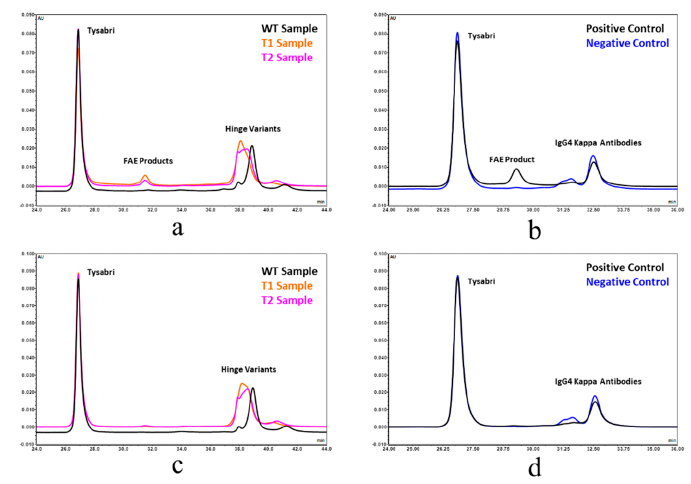
Figure 8. Blocking Fab arm exchange of hinge deleted mAbs by CH3 stabilization monitored by chromatographic separation. Propensity of IgG4 hinge deleted (T1), R409K CH3 stabilized IgG4 hinge deleted (T2), and S228P hinge stabilized full length IgG4 (WT) to engage in Fab arm exchange with Tysabri ® in the presence ( a ) or the absence ( c ) of 1 mM GSH reducing agent was analyzed by chromatographic separation. An FAE positive control reaction was conducted by monitoring the formation of the bispecific antibody by chromatographic separation between Tysabri ® and a nonhinge stabilized aGFP IgG4 antibody (IgG4 Kappa Antibody) in the presence ( b ) or the absence ( d ) of 1 mM GSH reducing